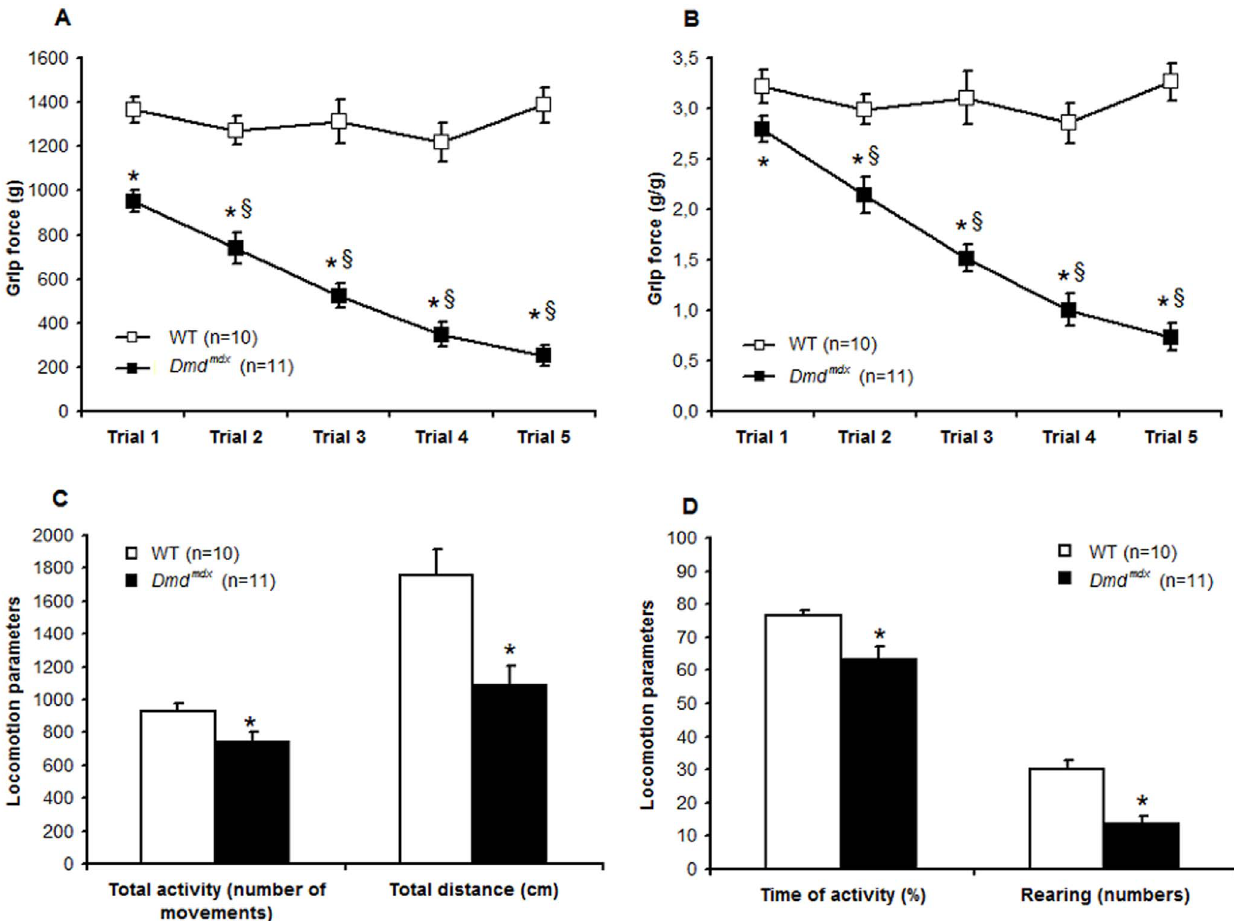
Figure 5. Dmd mdx rats are characterized by muscle weakness and by a decrease in a spontaneous activity. Forelimb grip test and locomotor activity of Dmd mdx rats were analyzed at the age of 3 months. Compared to wild-type littermate controls (WT), Dmd mdx rats were characterized by muscle weakness and showed a lower strength in absolute values ( A ) and when normalized to body weight ( B ). Dmd mdx rats showed fatigue with a decreased force grip across the five pulls, and significant values are obtained for the two last trials that were reduced to , 70% when compared to Trial 1. At 3 months, when compared to WT, Dmd mdx rats were less active and the number of movements ( C ), the total distance travelled ( C ), the time of activity ( D ) and the number of rearing ( D ) were significantly lower. Values are means 6 SEM; *p , 0.05 vs WT; 1 : p , 0.05 vs Trial